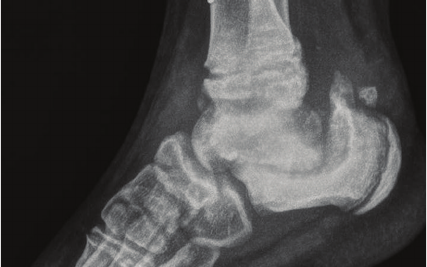
Figure 2: Demineralized bones and generalized osseous destruc-